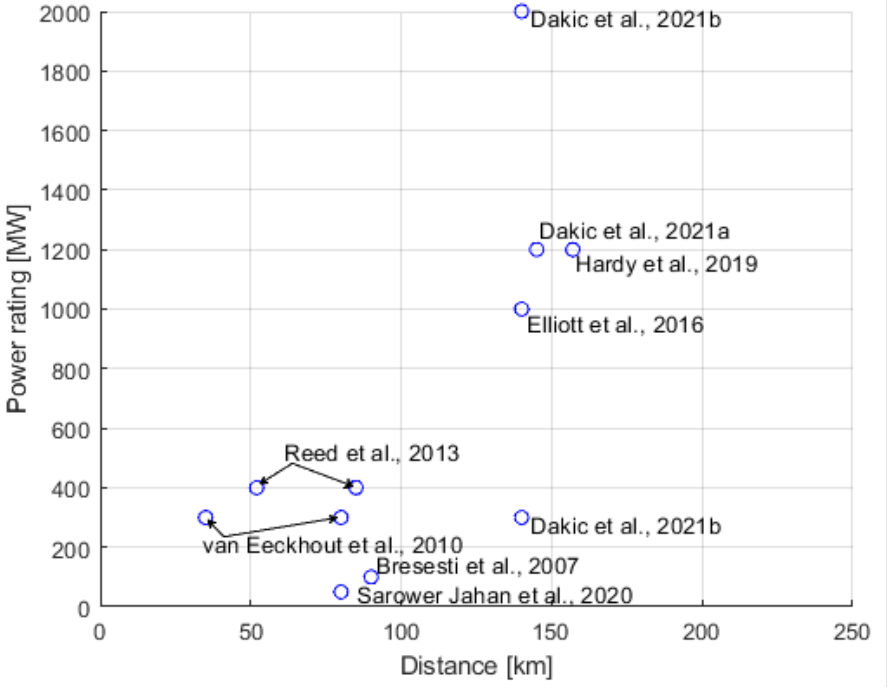
Figure 18. Break-even distances reported in studies [6,59,64–69]. Dakic et al. 2021a refers to [66] and Dakic et al. 2021b refers to [69]. Studies appearing twice have analyzed multiple scenarios.